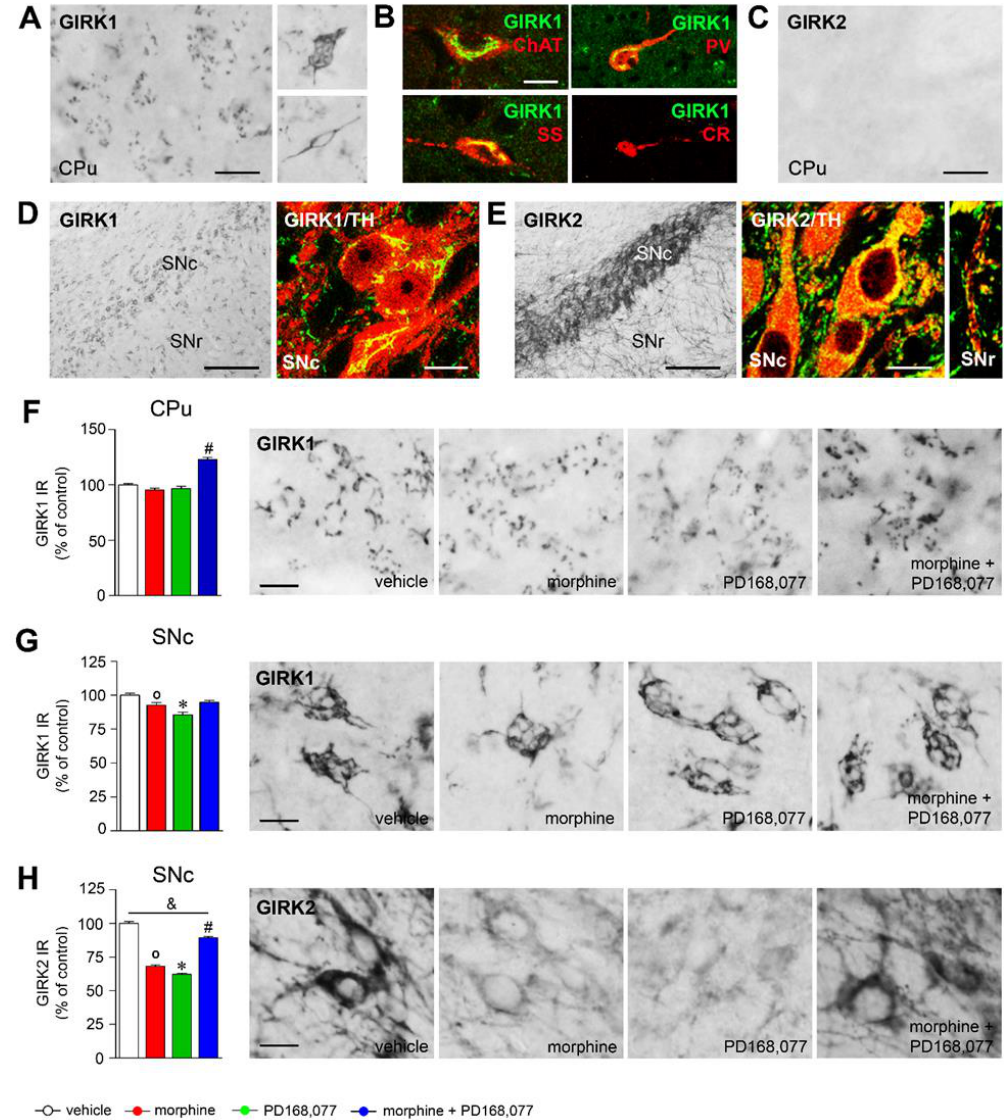
Figure 5. Effects of treatment with morphine and/or PD168,077 on GIRK1 and GIRK2 expression in the CPu and SNc. ( A ) Representative photomicrographs of coronal section of the CPu showing GIRK1 immunoreactivity (IR). The majority of the GIRK1 IR cells are MSNs (left panel in A) displaying a punctate labeling pattern, although few of them are larger cells depicting a reticular-like staining (right panels in A). ( B ) Photomicrographs illustrating by dual labeled immunohistochemistry with anti-GIRK1 (green) and anti-ChAT, anti-PV, anti-SS, and anti-CR (red) the expression of GIRK1 in striatal interneurons. ( C ) Representative photomicrograph showing the absence of GIRK2 expression in the CPu. ( D , E ) Photomicrographs illustrating GIRK1 ( D ) and GIRK2 ( E ) expression in the SN and their dual expression with tyrosine hydroxylase (TH). ( F – H ) Graphs represent the semi-quantitative analysis of GIRK1 IR in the CPu ( F ) and GIRK1 IR ( G ) and GIRK2 IR ( H ) in the SNc after the continuous (7 days) treatment with morphine (20 mg/kg/d) and/or PD168,077 (1 mg/kg/d). Next to the graphs, representative photomicrographs of GIRK1 and GIRK2 IR in the CPu and SNc are shown. Data represents mean ± SEM, n = 6 per treatment per treatment. Kruskal–Wallis test followed by Dunn’s method, ◦ p < 0.05 vehicle vs. morphine; * p < 0.05 vehicle vs. PD168,077; # p < 0.05 vehicle vs. morphine + PD168,077; & p < 0.05 morphine vs. morphine + PD168,077. Scale bars are: A,C: 30 µ m; B: 10 µ m; D,E (left panels): 200 µ m; D,E (right panels): 10 µ m; F,G,H: 10 µ m. Abbreviations: CPu, caudate putamen; SNc, substantia nigra pars compacta ; SNr, substantia nigra pars reticulata